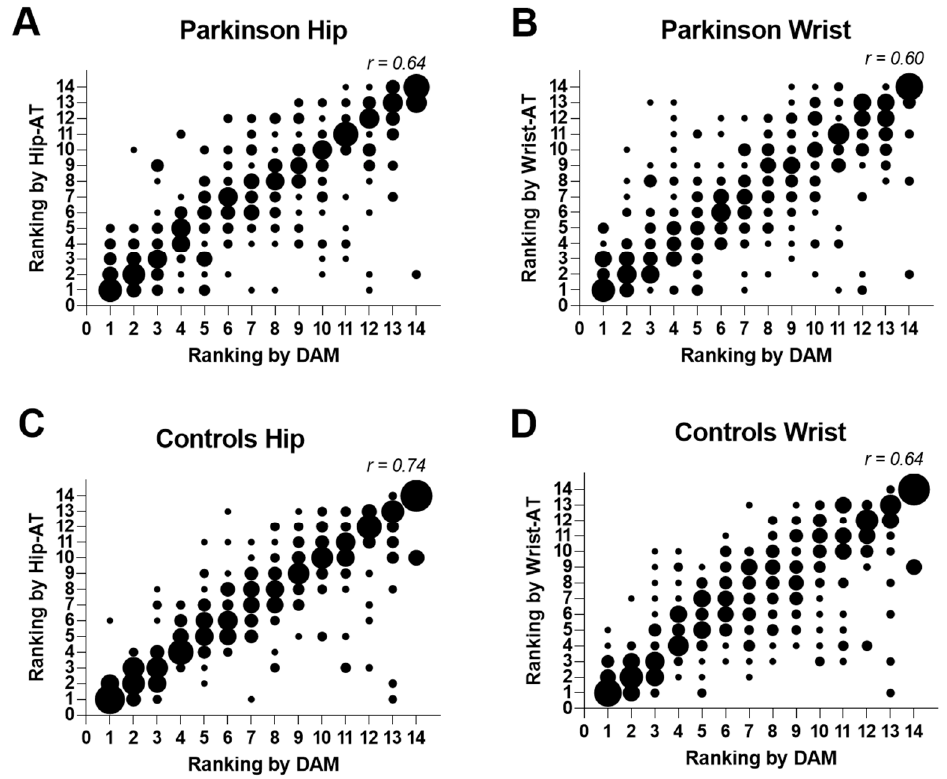
Figure 4. Ranking of steps/day by DAM compared to ranking by activity trackers. In PD, DAM compared to Hip-AT (panel ( A )) and compared to Wrist-AT (panel ( B )). In HC, DAM compared to Hip-AT (panel ( C )) and compared to Wrist-AT (panel ( D )). The larger the dot, the more subjects for the given combination of ranks. r = Kendall correlation for consistency of ranking. Hip-AT = Fitbit Zip or Fitbit Inspire; Wrist-AT = Fitbit Alta or Fitbit Inspire; DAM = Dynaport